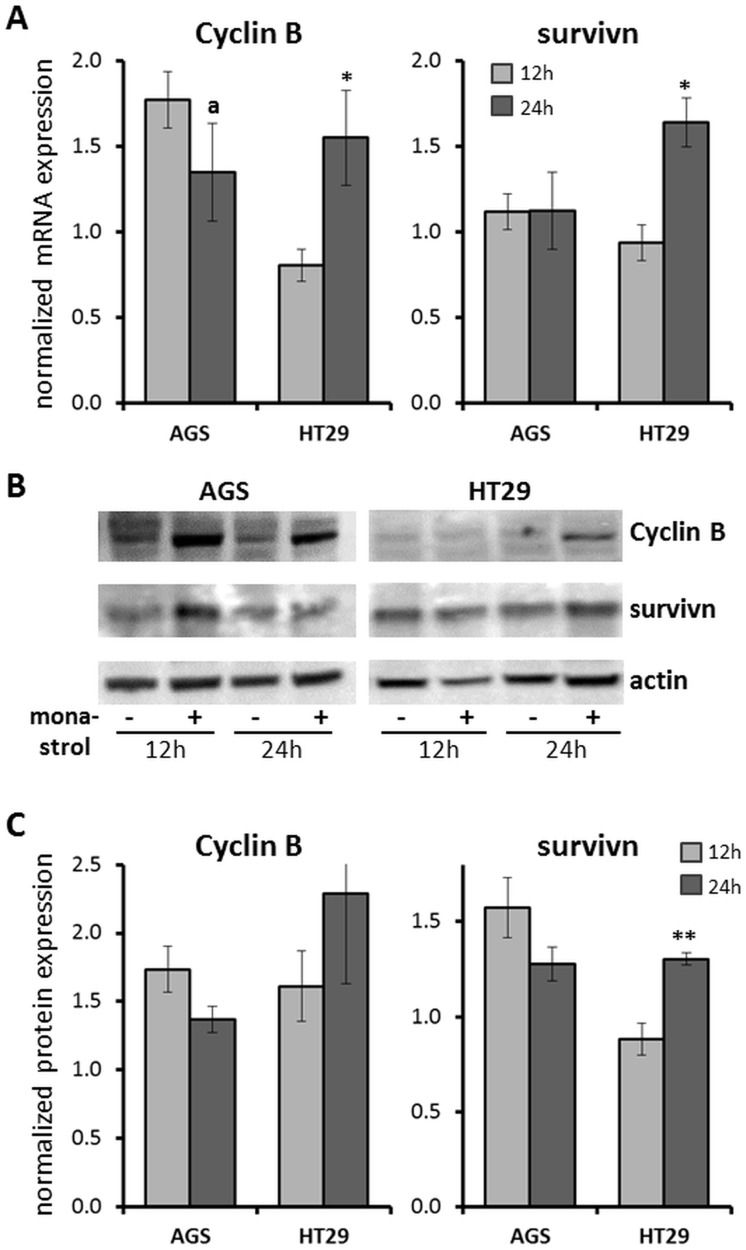
Expression levels of the mitotic cyclin B and survivin proteins.HT29 and AGS cells were treated with monastrol for 12h and 24h and processed for mRNA analysis by RT PCR (A) and protein level analysis by WB (B and C). 150μM and 100μM monastrol were used for HT29 and AGS cells, respectively. In A and C, columns and bars represent average and SEM values for 3–4 independent experiments. In each experiment, levels of cyclin B (left) and survivin (right), indicated at the top, in the presence of monastrol were normalized to the control values obtained with DMSO only. *P<0.05; **P<0.01; a—0.05<P<0.1 compared to 12h of monastrol treatment. (B) Representative WB analysis of cyclin B and survivin protein expression in AGS (left) and HT29 (right) cells treated with monastrol for 12h and 24h, indicated on the bottom. Equal protein loading was follow by the expression of actin (lower panels). (+) Monastrol; (-) DMSO.